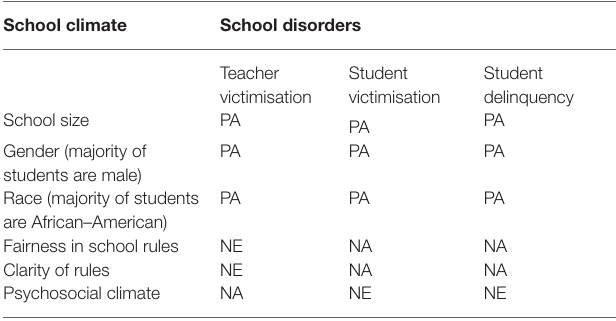
TABLE 4 | Show of associations between school climate and school